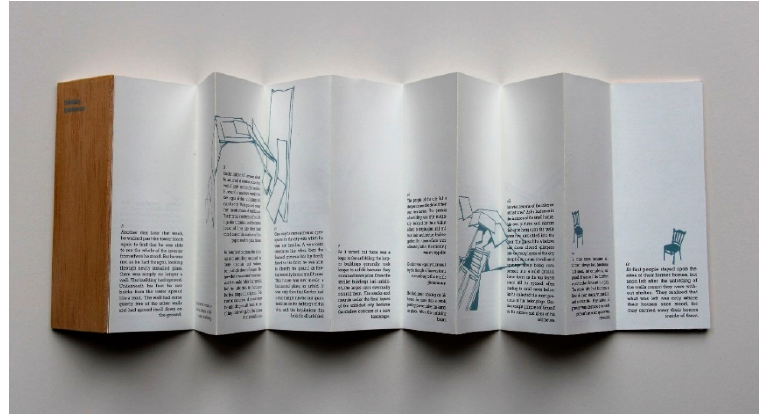
Figure 6. Unfolding Architecture (2007) by Emily Speed. Photo by Elaine Speight. Used with permission.